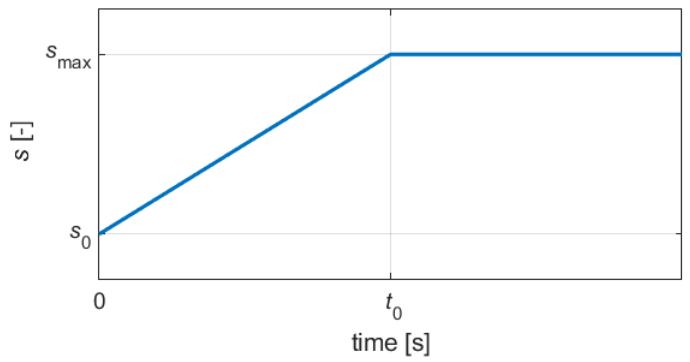
Figure 5. Waveform of the control signal, 𝑠 , for the proportional valve.